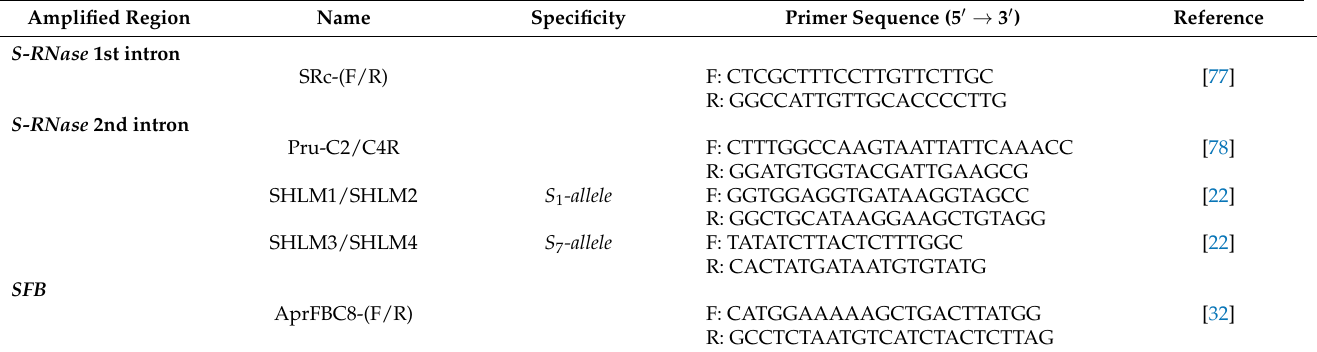
Table 5. SSR primers used in this study for the identification of S -alleles in apricot ( Prunus armeniaca ). Amplified Region